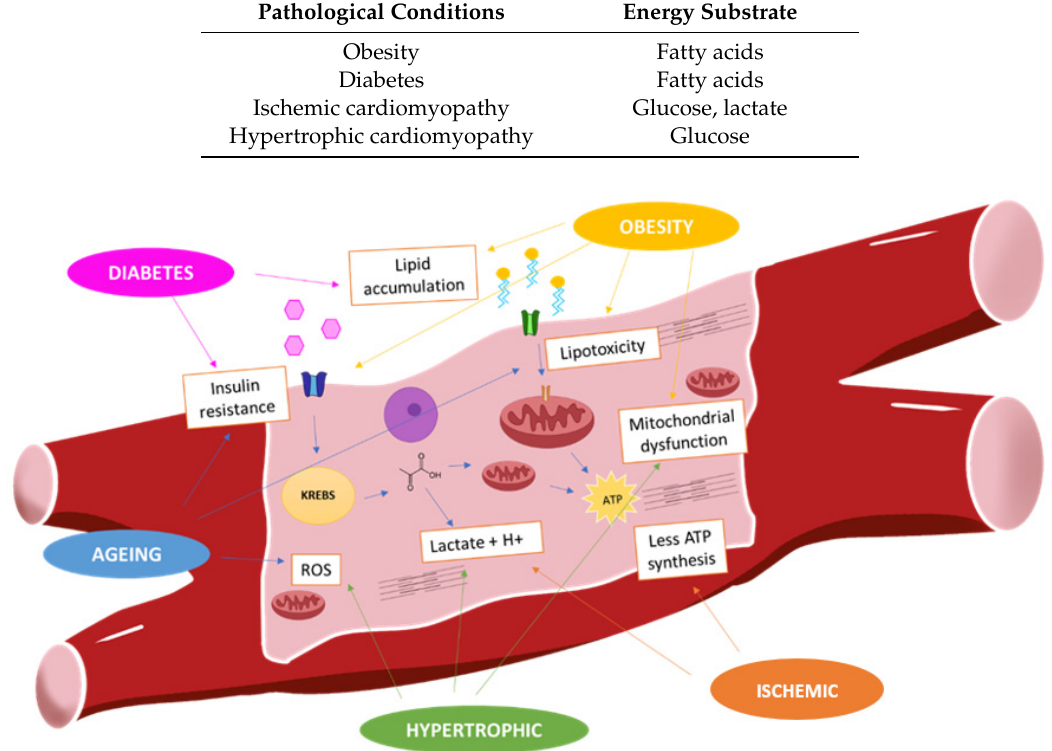
Figure 1. Myocardium metabolism in pathological situations: In physiological conditions, fatty acids are mainly fuel of energy of cardiomyocytes. Obesity is associated with high fatty acids uptake that develops lipotoxicity and insulin resistance. It reduces the glucose uptake. However, during hypertrophic and ischemic situation, there is shift from fatty acids to glucose that is converted into lactate. This metabolism gets less ATP production, and there is mitochondrial dysfunction and ROS (reactive oxygen species)